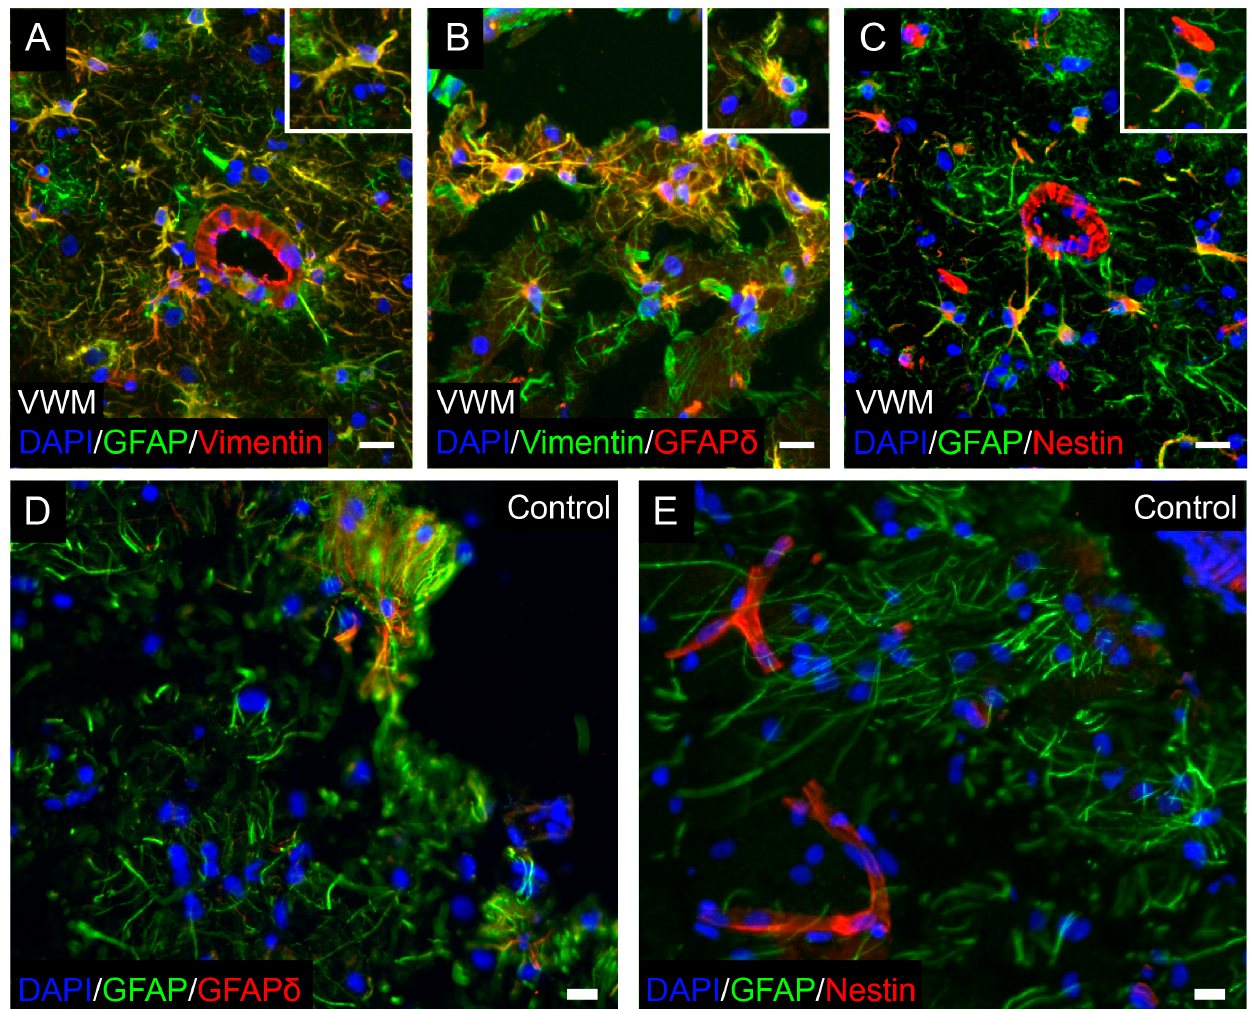
Figure 8. Astrocytes in the VWM cortex are immature and have a disrupted intermediate filament network. Double stain in VWM cortex against ( A ) GFAP (green) and vimentin (red), ( B ) vimentin (green) and GFAP δ (red), and ( C ) GFAP (green) and nestin (red). Insets show double-labeled cells. Double stain in control cortex for ( D ) GFAP (green) and GFAP δ (red), and ( E ) GFAP (green) and nestin (red). Blue stain indicates nuclei. Scale bars: 20 µm. Depicted images are stains of control 4 and VWM 3.